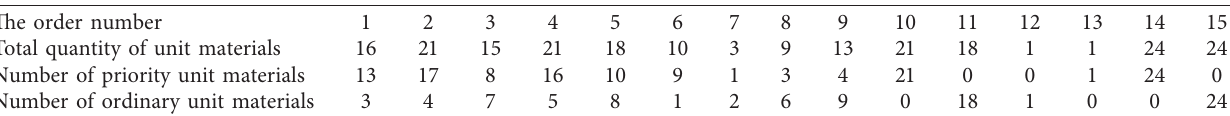
Table 1: Product order data.